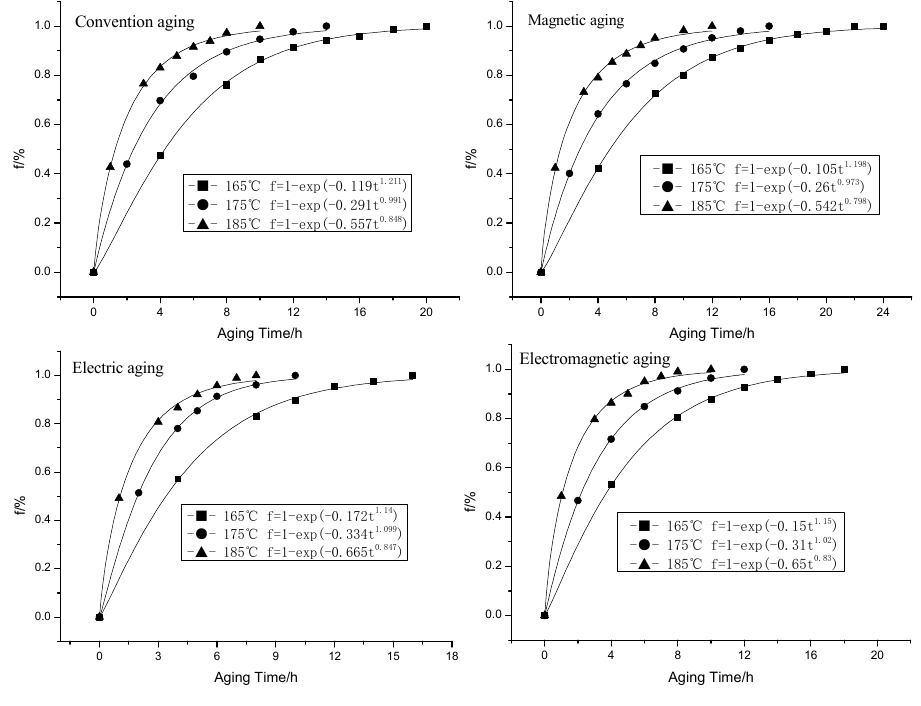
Figure 3. Fitting of aging kinetics curves.